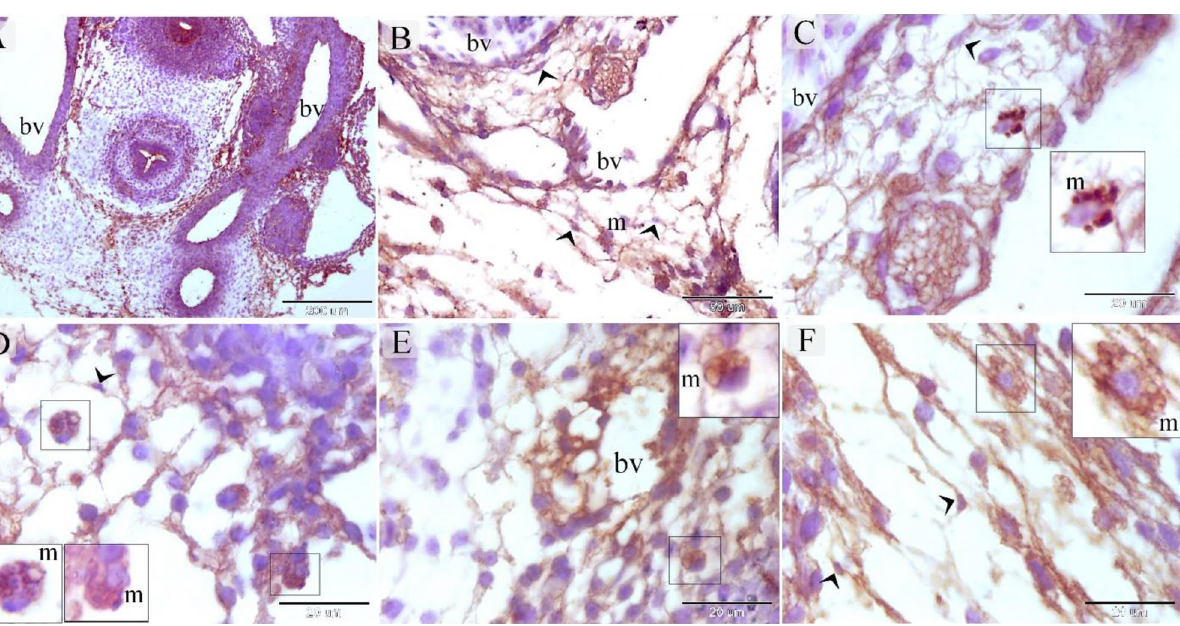
Figure 8. Immunohistochemical staining of the neck skin at day 5 and day 8 using CD68. ( A ) general view of the neck region at day 5 showing blood vessels (bv). ( B , C , D ) Vascular area of the neck skin of quail embryos at day 8. Note CD68 + ve macrophage (m), CD68 + ve TCs (arrowheads), blood vessel (bv). ( E , F ) Vascular area of the neck skin of quail embryos at day 5. CD68 + ve macrophage (m), CD68 + ve TCs (arrowheads), blood vessel